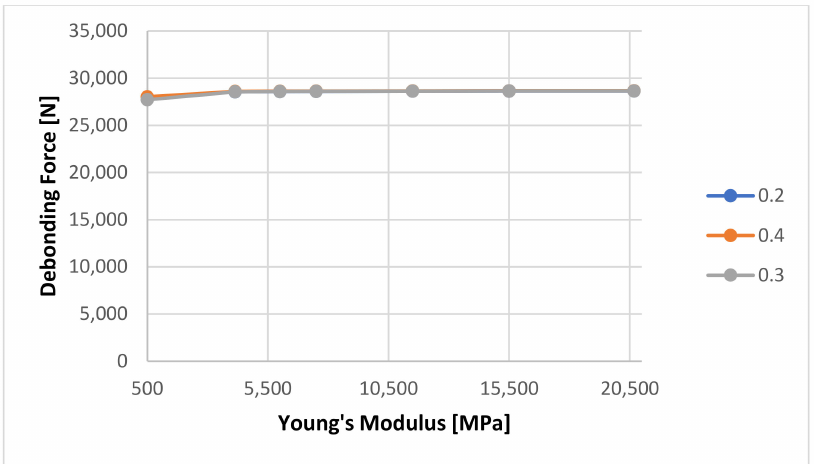
Figure 17. Calculated debonding force as a function of Young’s Modulus of the cement for 7 days curing time, please note that all three lines are overlapping showing just one gray line.